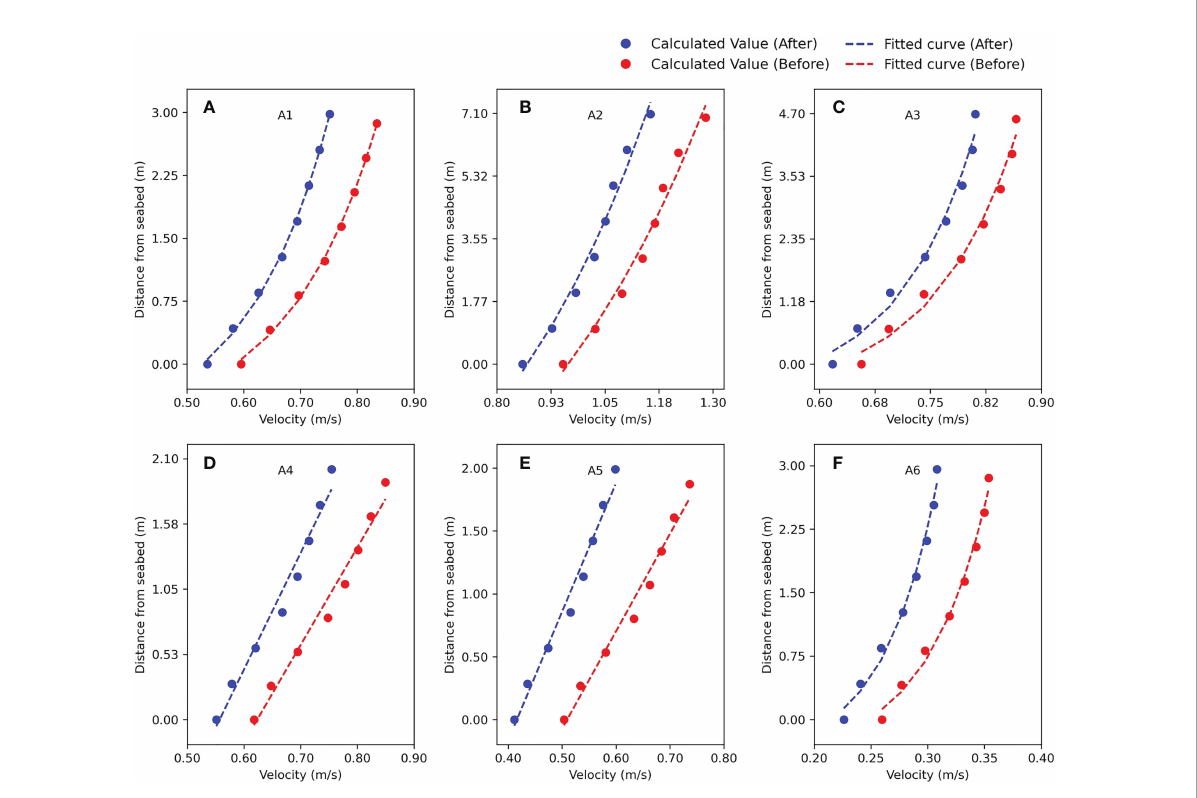
FIGURE 10 Calculated values and fi tted curves of vertical fl ow velocity at characteristic points of peak fl ood tide of spring tide before and after human engineering activity. (A – F) Characteristic points A1 to